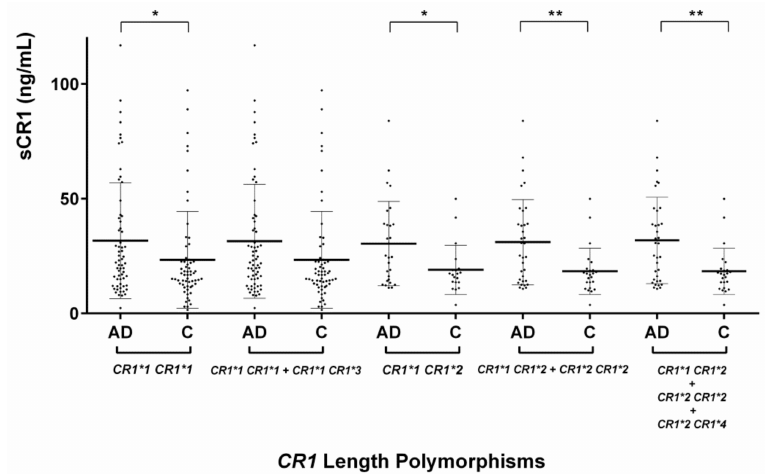
Figure 2. Comparison of soluble complement receptor 1 (sCR1) levels according to CR1 length polymorphisms in Alzheimer’s disease (AD) patients and controls. The middle line indicates the mean value, and the upper and lower horizontal bars indicate the standard deviation values. A Student’s t -test was used to compare AD patients with controls according to CR1 length polymorphisms for normally distributed variables; * p < 0.05, ** p <